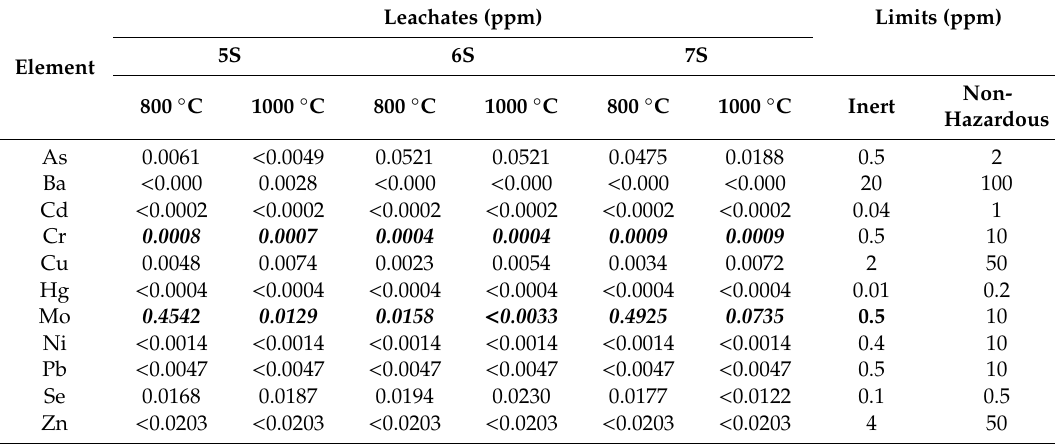
Table 4. Leachate Chemical Analysis of Selected Samples Fired at 1000 °C (in N 2 ). Bold: highlighted pollutants; Italic: reference data for previously developed samples fired in air.